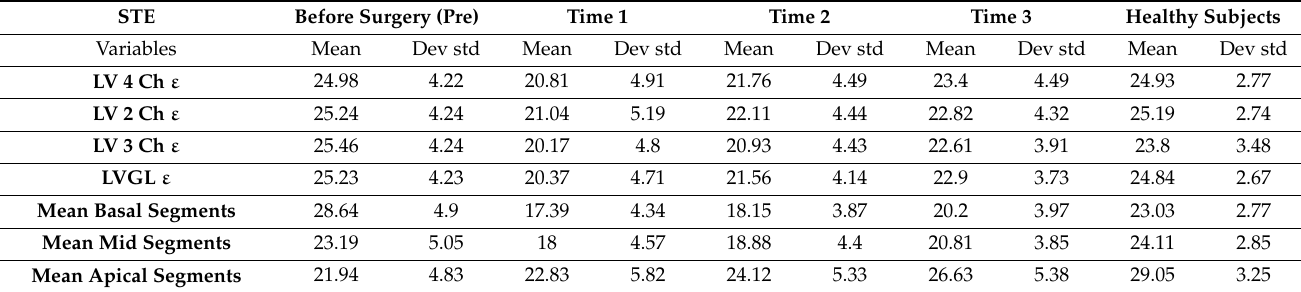
Table 3. Mean and standard deviation of LV ε values at different time evaluations.